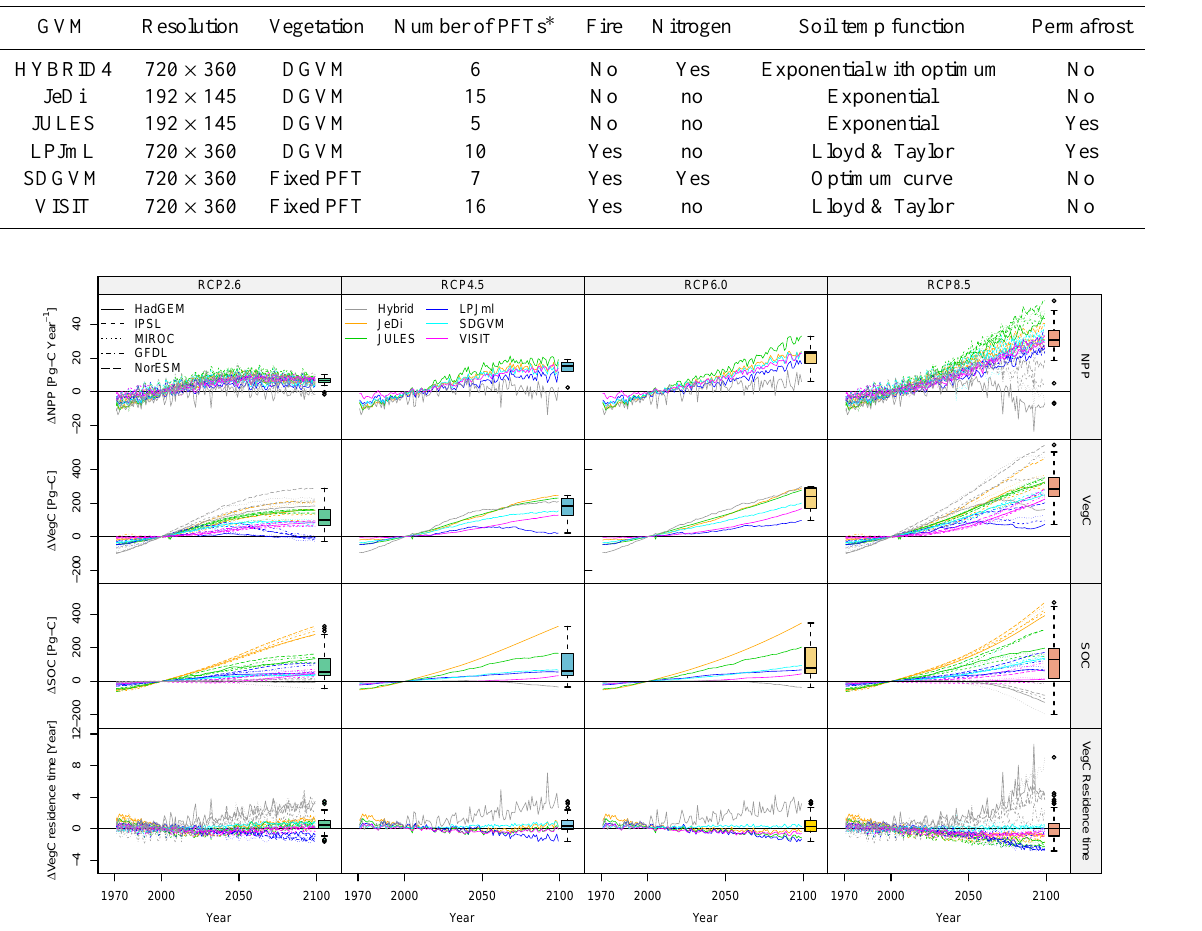
Table 1. General properties of biome models. ∗ PFT indicates plant functional type.